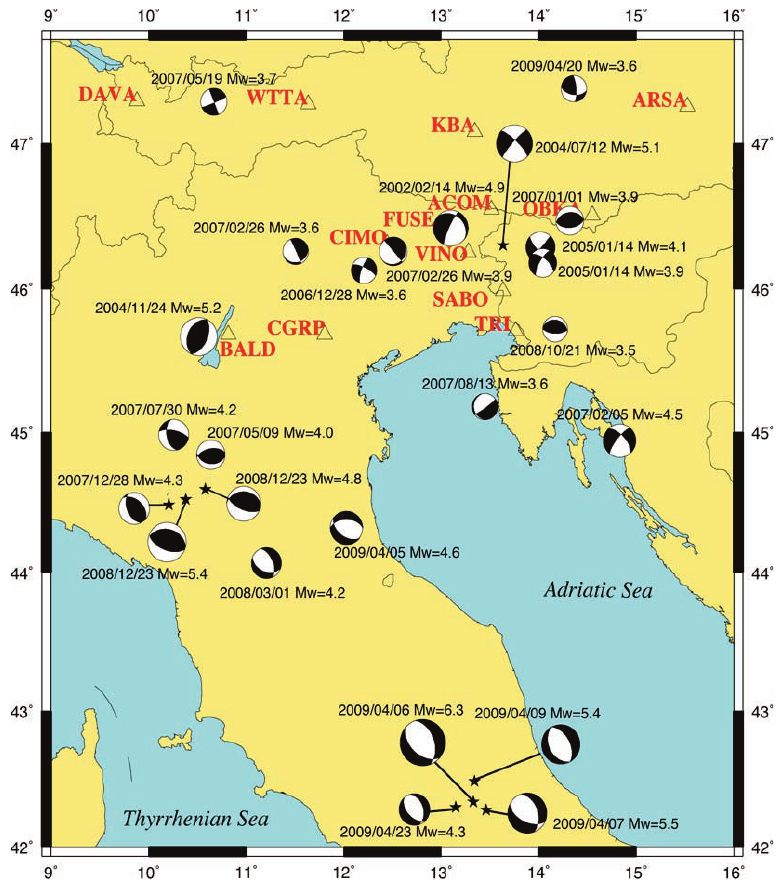
Figure 8. Some of the moment tensor computed using waveforms collected in real-time at the OGS from broad-band seismic stations (triangles). The moment tensors of the 2009 L'Aquila earthquake (Mw = 6.3), together with some of the aftershocks, were computed to test our procedure.